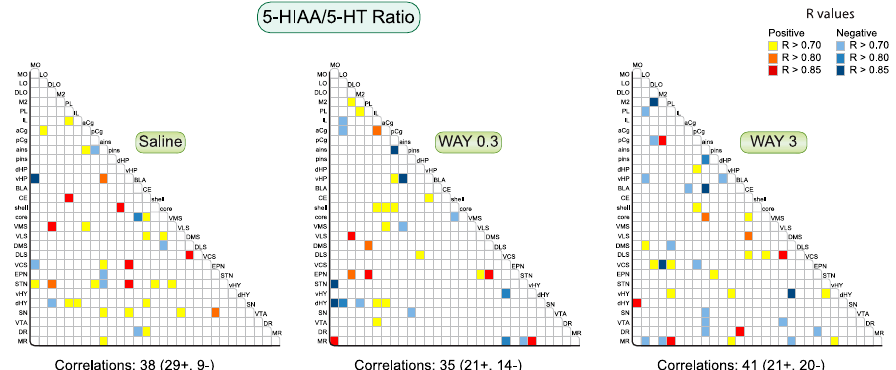
Figure 2. Correlative analysis of neurochemical indexes of 5-HT turnover (5-HIAA / 5-HT ratio) across rat brain regions. Representation of the range of Pearson’s r values for each linear regression, 5-HIAA / 5-HT ratio between the 29 brain areas in saline, WAY-163909 0.3 mg/kg, and 3 mg/kg treated rats. Colored boxes correspond to the existence of a significant correlation between the two parameters (yellow to red: positive; blue: negative) considered after correction for multiple comparisons.